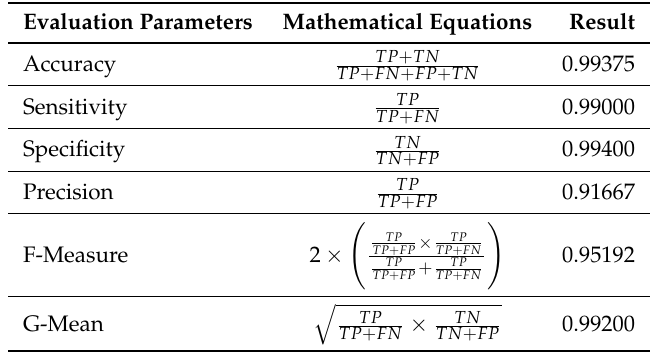
Table 3. Training performance with respect to common performance metrics.